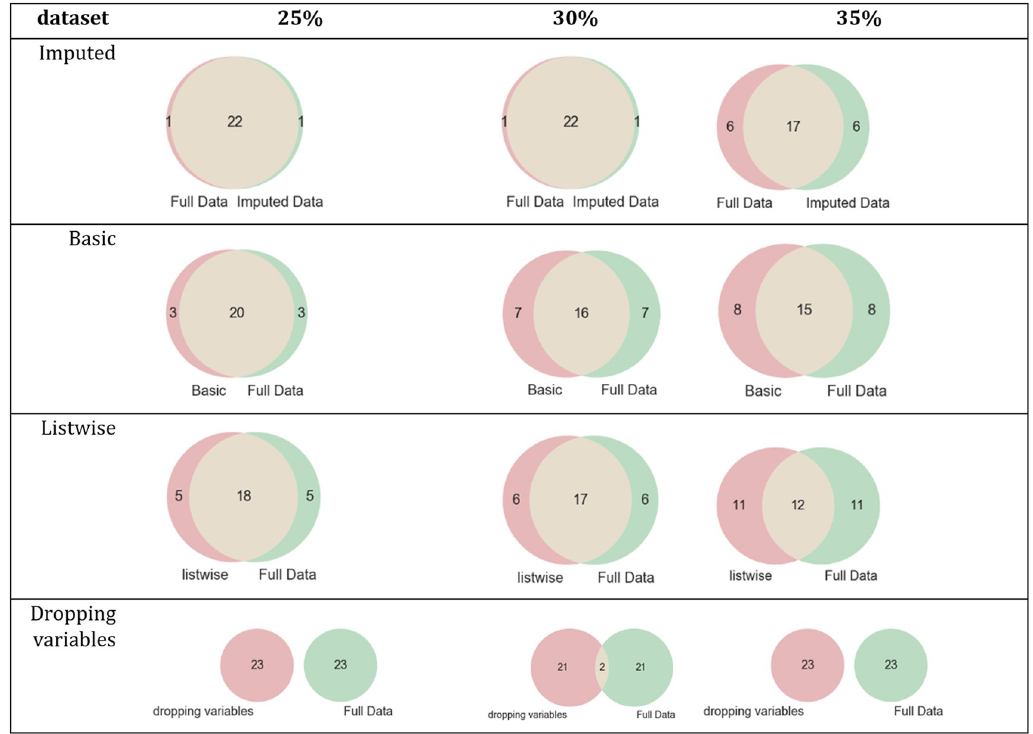
Fig 10. Intersections of sets of relevant features of the spambase dataset and its simulated datasets.